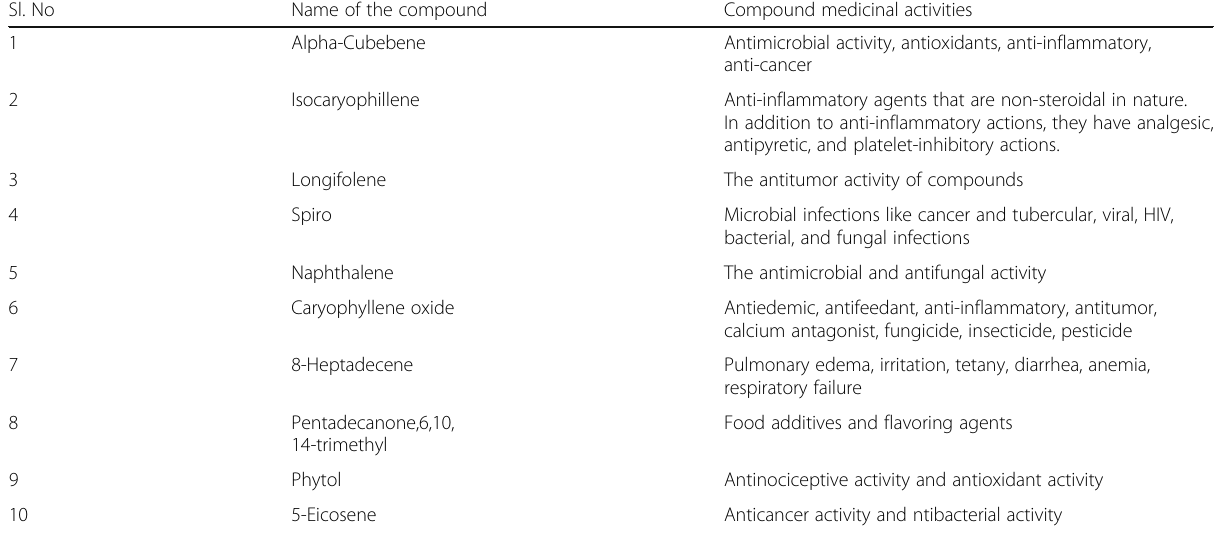
Table 3 Activity of phyto-components identified in medicine of essential oil from the leaves of L . aspera Sl. No